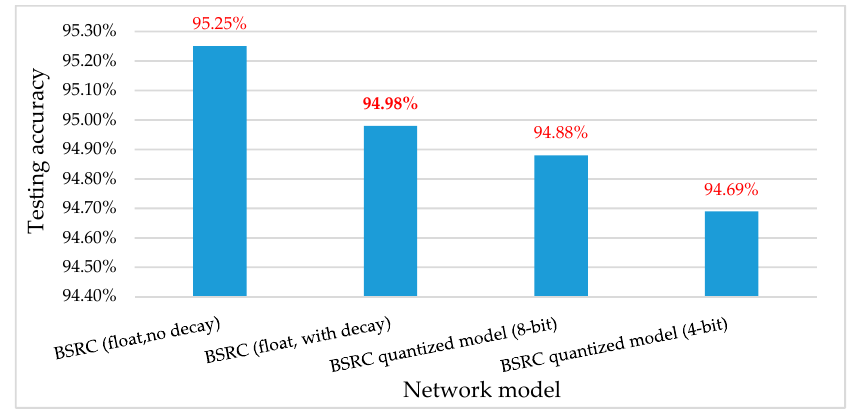
Figure 12. Accuracy of SNNs with optimized structure (81-30-20-10) trained with decay factor = 1 (no decay), decay factor = 0.5, and quantized weight (8-bit and 4-bits) resolutions.